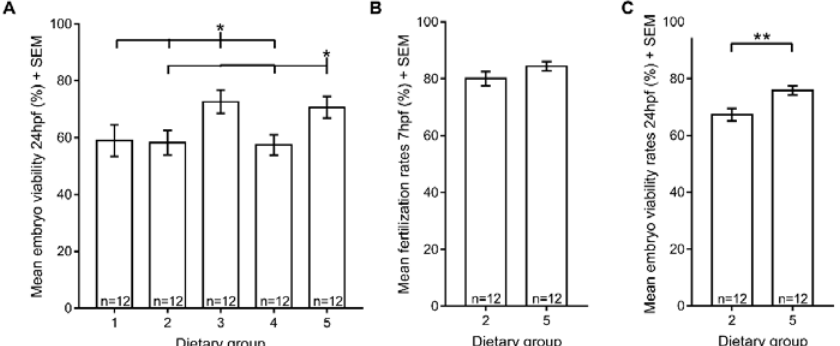
Figure 4. Reproductive performance is affected by processed feeds but not by rotifers. ( A ) Mean embryo viability at 24 hpf; ( B ) mean fertilization at 7 hpf for dietary groups 2 and 5; ( C ) mean embryo viability at 24 hpf for dietary groups 2 and 5. Statistically significant differences in reproductive parameters are depicted: * p < 0.05, ** p < 0.01, *** p < 0.001. Group 1, Zeb. + Rot. <60 dpf, Zeb. >60 dpf; Group 2, Gem. + Rot. <60 dpf, Gem. >60 dpf; Group 3, Zeb. + Rot. <15 dpf, Zeb. >15 dpf; Group 4, Gem. + Rot. <15 dpf, Gem. >15 dpf; Group 5, Gem. + Rot. <60 dpf, Zeb. >60 dpf (Zeb = Zebrafeed ® ; Gem = GemmaMicro ® ; Rot = rotifers).